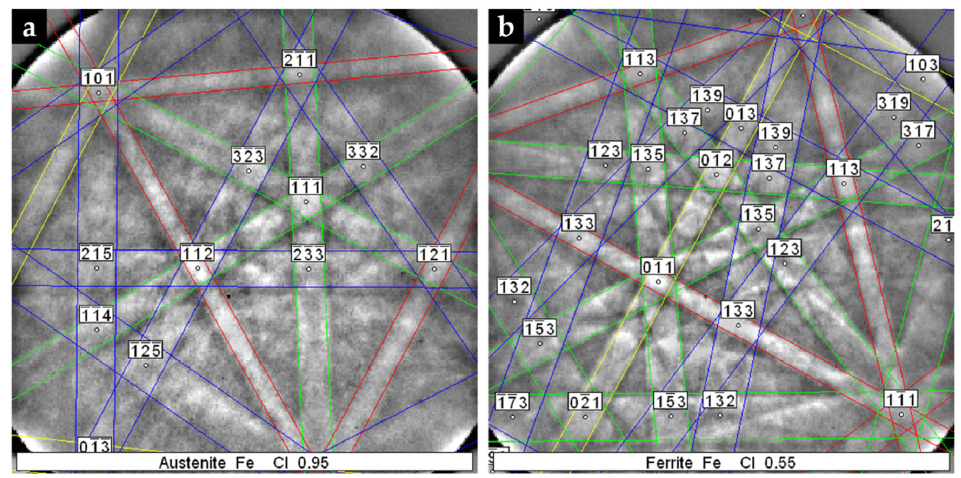
Figure 11. Indexed EBSD patterns corresponding to the phases that compose the microstructure of the austenitic stainless steel: austenite ( a ) and ferrite ( b ).